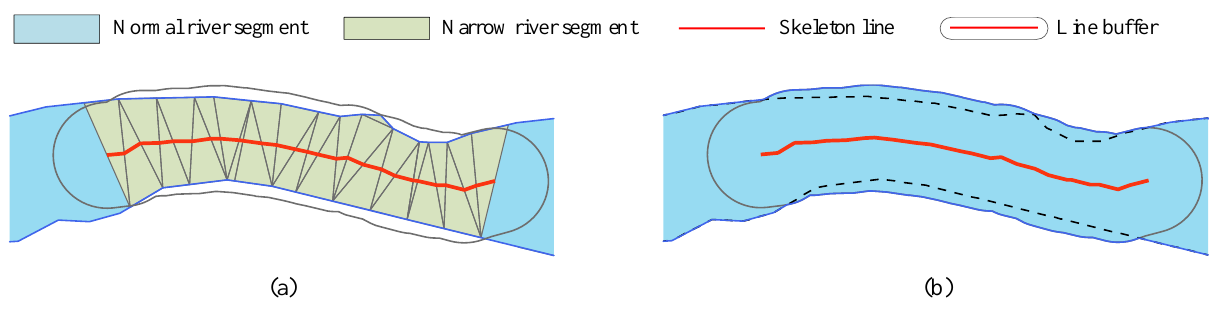
Figure 9. Exaggeration of the river segment: ( a ) before exaggeration handling; ( b ) after exaggerated handling.